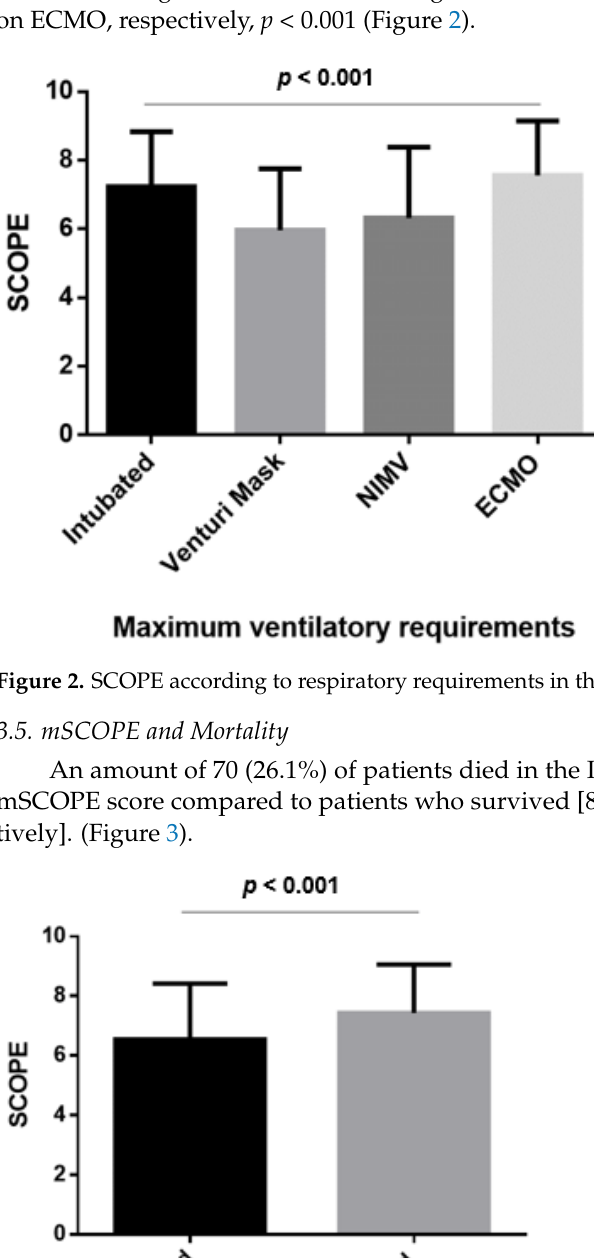
An amount of 146 (54.5%) of patients were intubated, and 52 (19.4%) patients were us- ing Venturi masks, and 61 (22.8%) patients were using non-invasive mechanical ventilation, and nine (3.4%) patients required ECMO. Patients who required mechanical ventilation and those required ECMO had higher mSCOPE scores compared to those who had lower ventilatory requirements, i.e., 7 (6, 9) vs. 6 (5, 7) vs. 7 (4.5, 8.0) vs. 8 (6, 9) for patients been intubated, using Venturi masks and using non-invasive mechanical ventilation and patients on ECMO, respectively, p < 0.001 (Figure 2). Figure 2. SCOPE according to respiratory requirements in the study subjects.